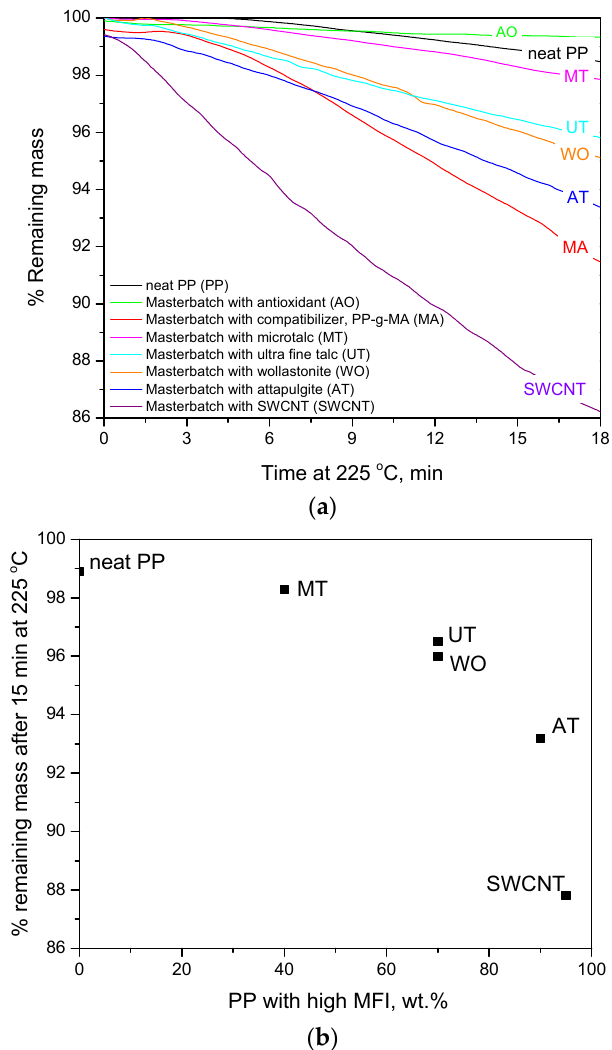
Figure 2. ( a ) TGA curves at constant temperature of 225 °C for the masterbatches used in this study. ( b ) Remaining mass of the masterbatches after 15 min at 225 °C as a function of their content in high MFI PP.